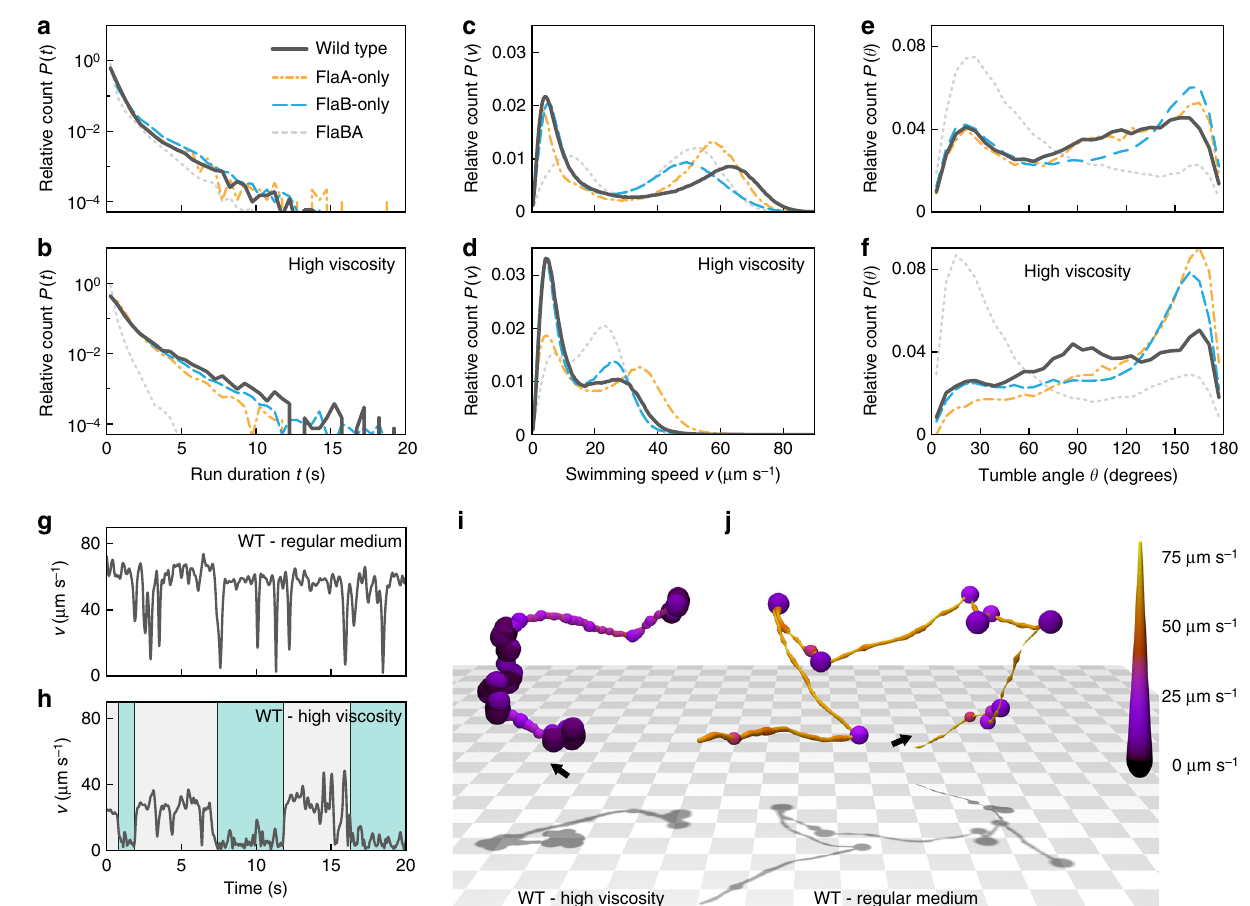
Fig. 3 Free-swimming behavior mediated by the four different fl agellar fi lament types. Several thousand cell tracks were obtained for each strain by holographic microscopy. The diagrams show the relative counts to account for different sample sizes. a , b Run duration histograms for wild-type (FlaAB, dark grey solid lines), FlaA-only (orange mixed dashed lines), FlaB-only (blue long dashed lines) and FlaBA (light grey short dashed lines) cells in regular medium (upper panel) and medium with increased viscosity (lower panel). P ( t ) indicates the probability of observing a run with a duration in the range t to t + d t . c , d Velocity distribution for the different fi lament types in regular medium and medium with increased viscosity, respectively. P ( v ) indicates the probability of observing a cell swimming with a speed in the range v to v + d v . e , f Turning angle histograms for the different fi lament types in regular medium and medium with increased viscosity, respectively. Low and high turning angles correspond to weak deviations from straight swimming and near- reversals, respectively. P ( θ ) indicates the probability that a particular re-orientation event results in a change of direction in the range θ to θ + d θ . g , h Velocity series for a single wild-type cell in regular medium and a similar cell in high viscosity medium, respectively. Under conditions of increased viscosity the cell exhibits longer periods of swimming at a slower speed (the cyan-colored areas in panel h ), indicative of screw formation. i , j Stereotypical cell tracks for wild-type cells in medium with increased viscosity (left) and regular medium (right). The tracks correspond to the velocity series in panels g and h . The starting points of the tracks are marked by arrows. The color coding and the line thickness represent the cells ’ swimming speed. The corresponding movie is provided as Supplementary Movie